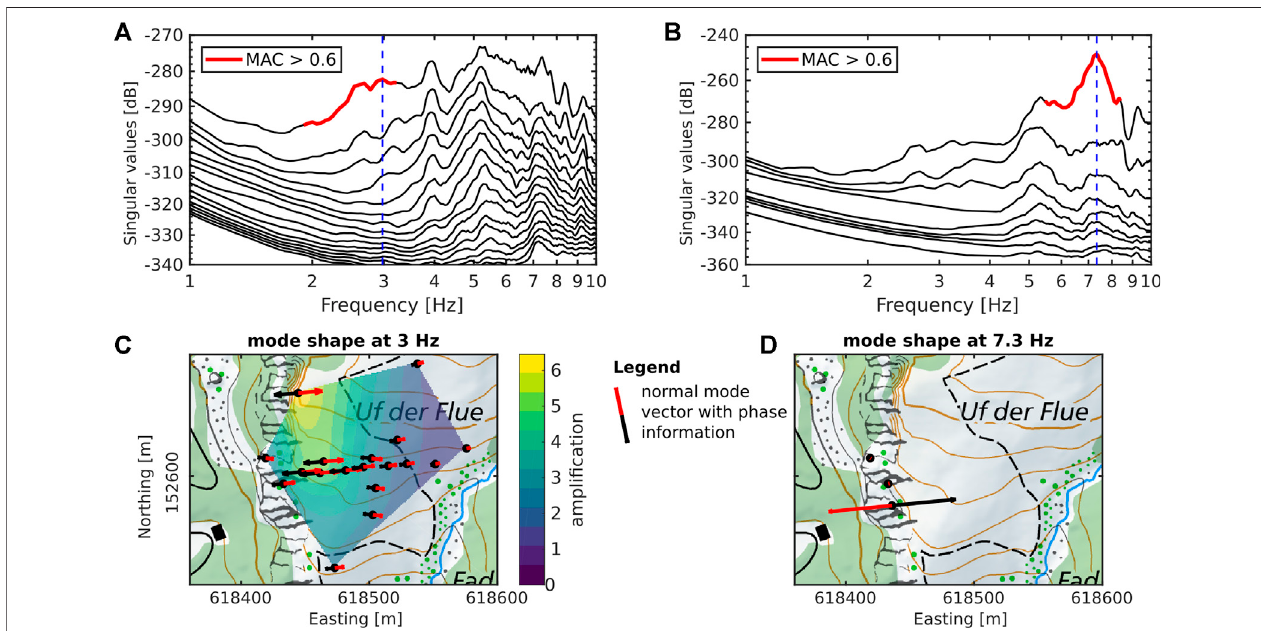
FIGURE 3 | Results of the Frequency Domain Decomposition (FDD) modal analysis; (A) the singular value plot of all stations shows two broad peaks at 3 Hz and about5.8 Hzandseveralnarrow-bandedspikes,forexample,at4 Hz,5.2Hz,7.4Hz,and14.6Hz;theredcolorindicatesthebandwidthwithaMAC > 0.6comparedto the picked frequency (blue dashed line); the peak at 3 Hz is interpreted as the fundamental resonant mode of the structure; (B) the SVP for stations located at Dreispitz (108, 109, 110) is characterized by a broad peak at 3 Hz (same peak as visible on the other stations) and a very strong peak at 7.3 Hz (blue dashed line); (C) Ampli fi cation map of the mode shape at 3 Hz for all stations at Flue with arrows indicating the normal mode vector (polarization). The color of the arrows represents the phase information; (D) Ampli fi cation map of the mode shape at 7.3 Hz for the stations at Dreispitz (108, 109,